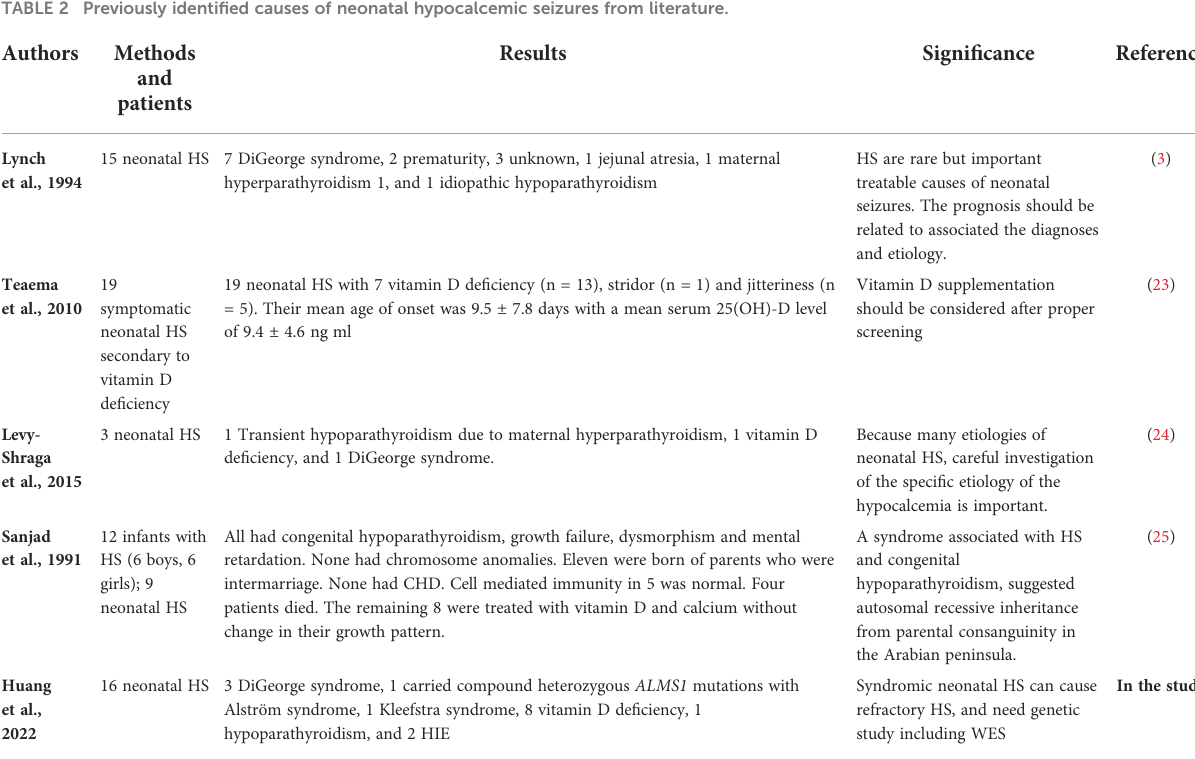
TABLE 2 Previously identi fi ed causes of neonatal hypocalcemic seizures from